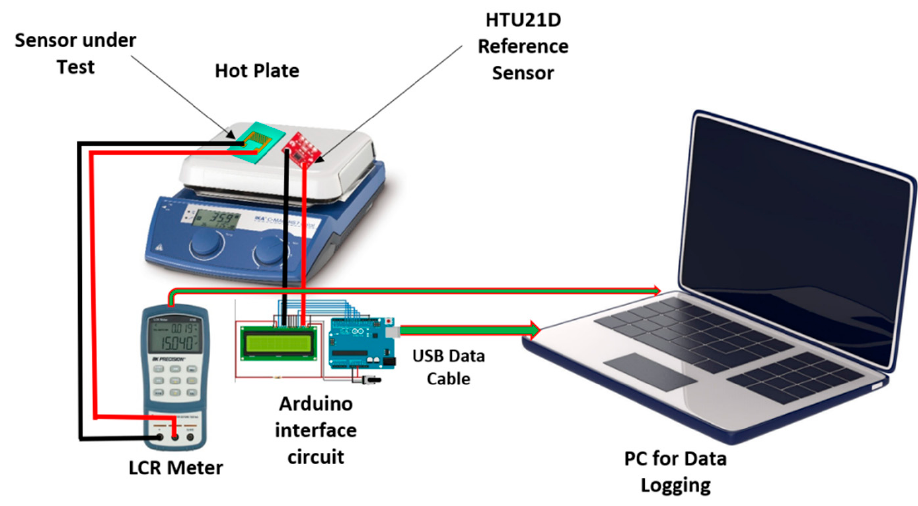
Figure 6. In-house built characterization setup for electrical characterization of temperature sensor.